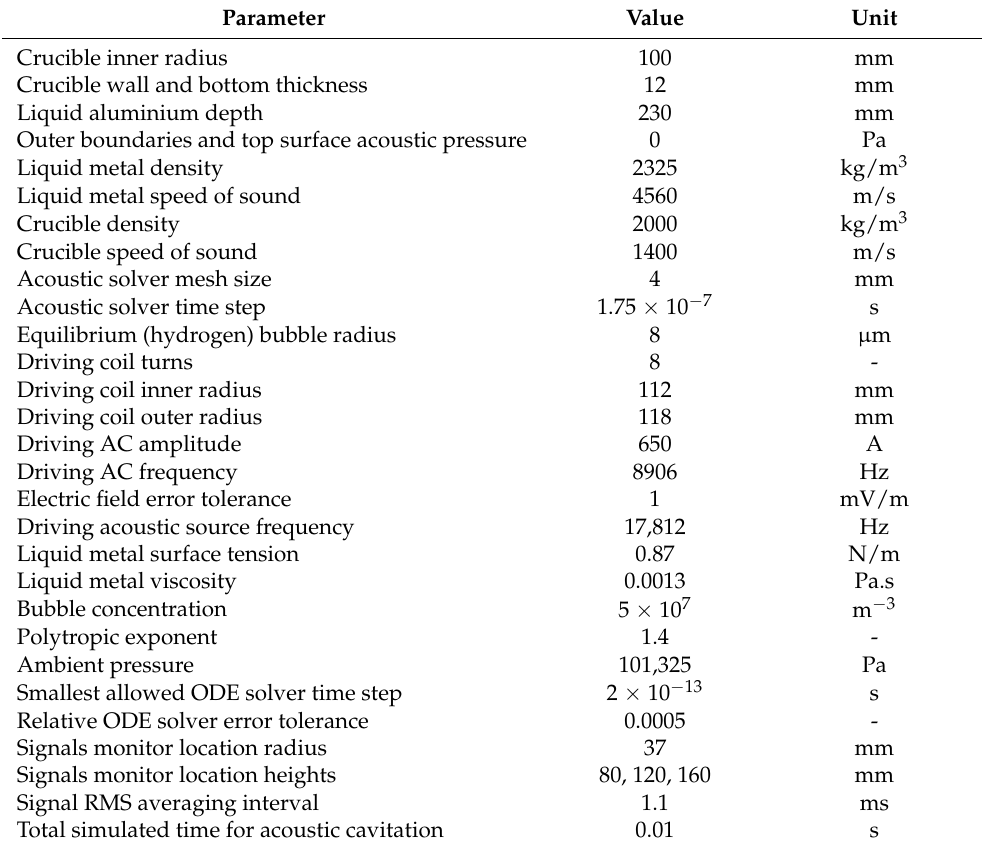
Table 1. Simulated case